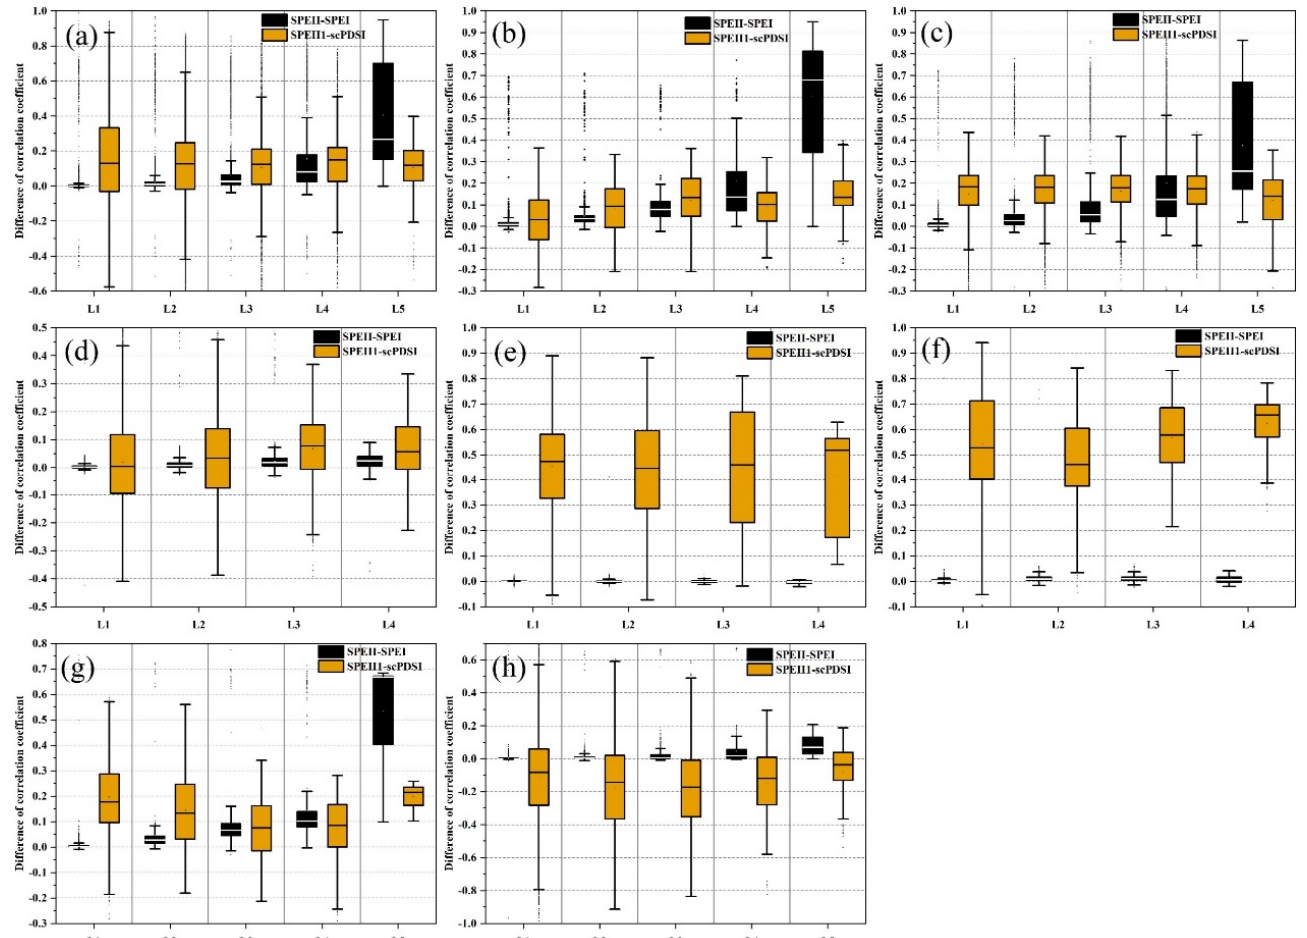
Figure 4. Vegetation response degree to the SPEII ( a ) and SPEI ( b ). The difference value between the vegetation response degree to the SPEII and SPEI (a minus b) ( c ). Vegetation response time to the SPEII ( d ) and SPEI ( e ). The difference value between the vegetation response times to the SPEII and SPEI (d minus e) ( f ).